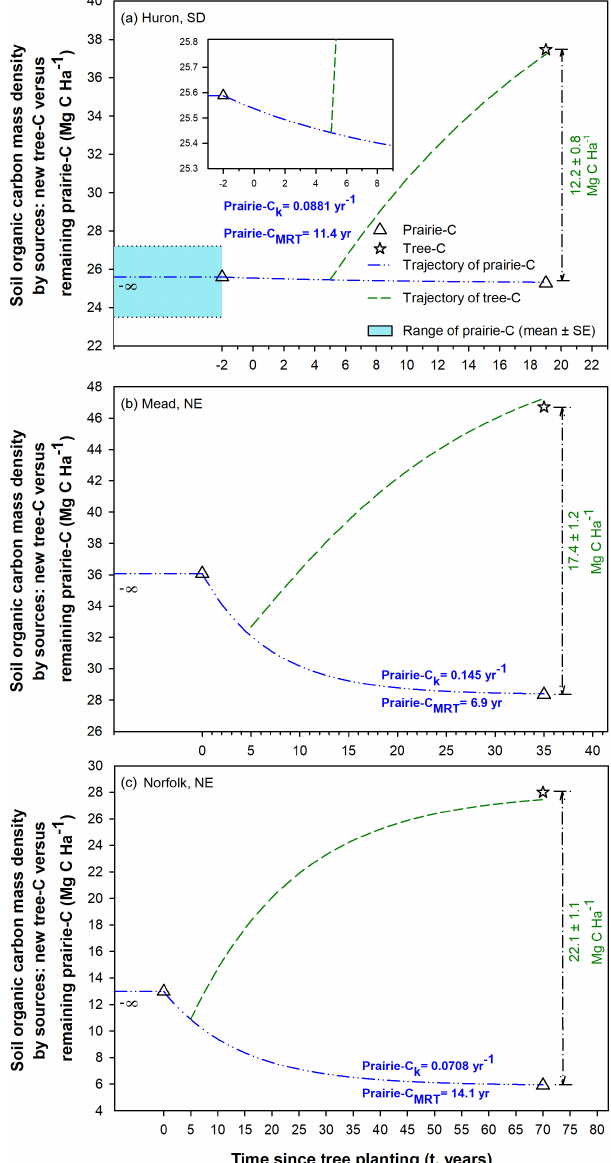
Figure 7. Net carbon accretion in afforested soils caused by simul- taneous C gains from substantial tree-C contributions and smaller C losses from mineralization of remaining prairie C. It was inferred that all soil C different from new tree C was pre-existing soil C at- tributable to remaining prairie C. Time of tree planting was set at the year zero. Based on a literature review by Paul et al. (2002), we in- cluded a lag phase of 5 years following tree planting. The accretion trajectories of tree C presented within each panel were projected using the unified first-order model developed in Fig. 6. The magni- tude of tree-C gains as well as the turnover rates ( k ) and mean resi- dence time (MRT) of prairie-C trajectories are provided within each panel. The Huron site (a) had an adjacent native grassland available, which here is provided as a reference and plotted prior to the time of conversion into annual cropland. Note the different x and y scales across